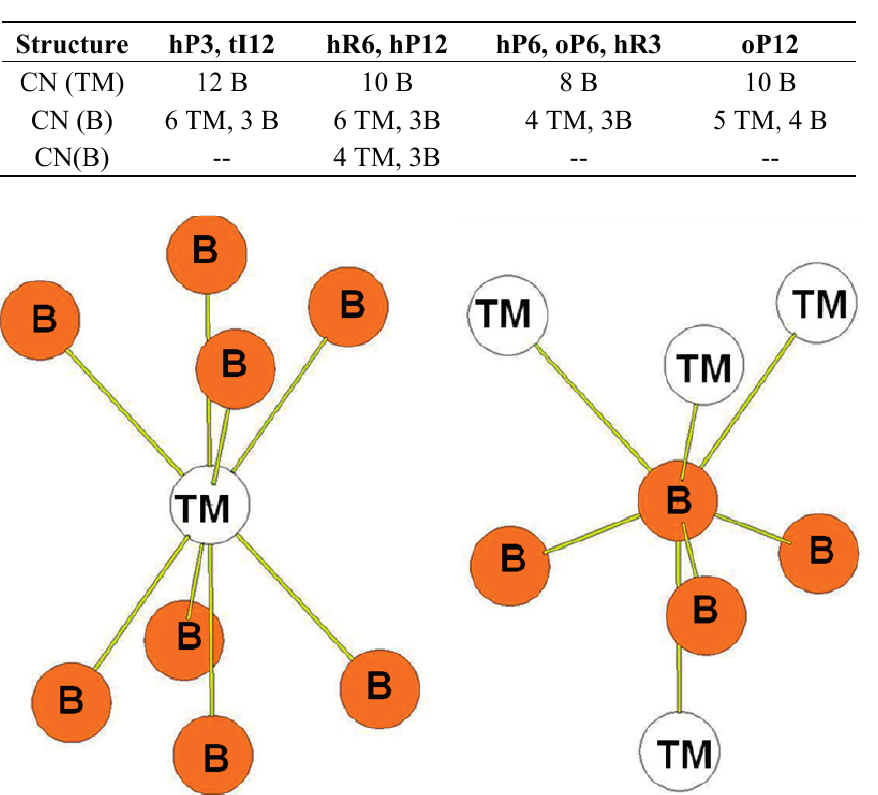
Table 9. Coordination numbers of the TM and B atoms in the hP3, tI12, hR6, hP12, hP6, oP6, hR3, and oP12 structures.